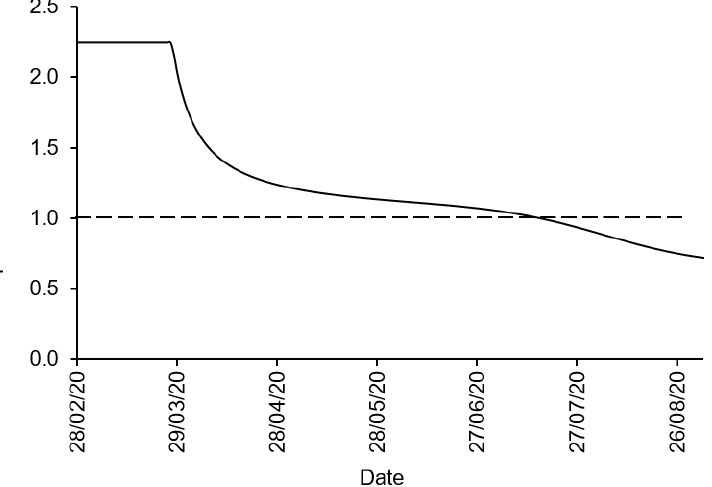
Figure 5. Time varying effective reproduction number of the 2020 COVID-19 epidemic in West Africa using daily case reporting data (28 February to 31 August 2020). The estimate is based on a SIQR model (see (16)–(19)) with rate parameters δ = 0.009 day − 1 (detection rate), γ = 1/11.9419 day − 1 (recovery rate for non detected), π = 1/61.4953 day − 1 (death rate for non detected), η = 35,615.35 individuals/day (recruitment rate) and µ = 2.1745 × 10 − 5 day − 1 (natural mortality